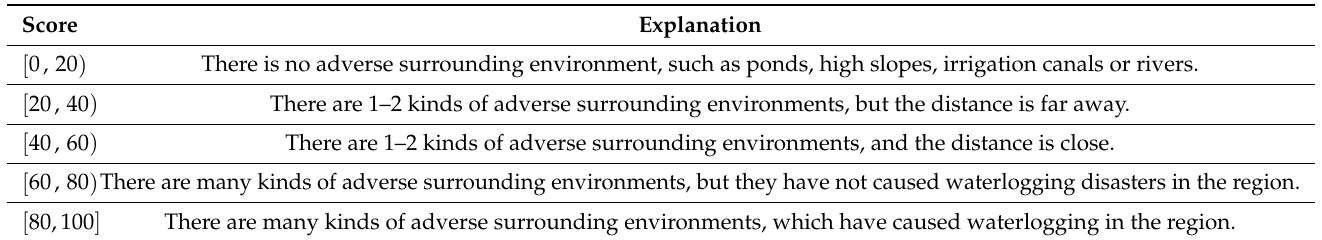
Table 2. Score basis of unfavorable geomorphological features.